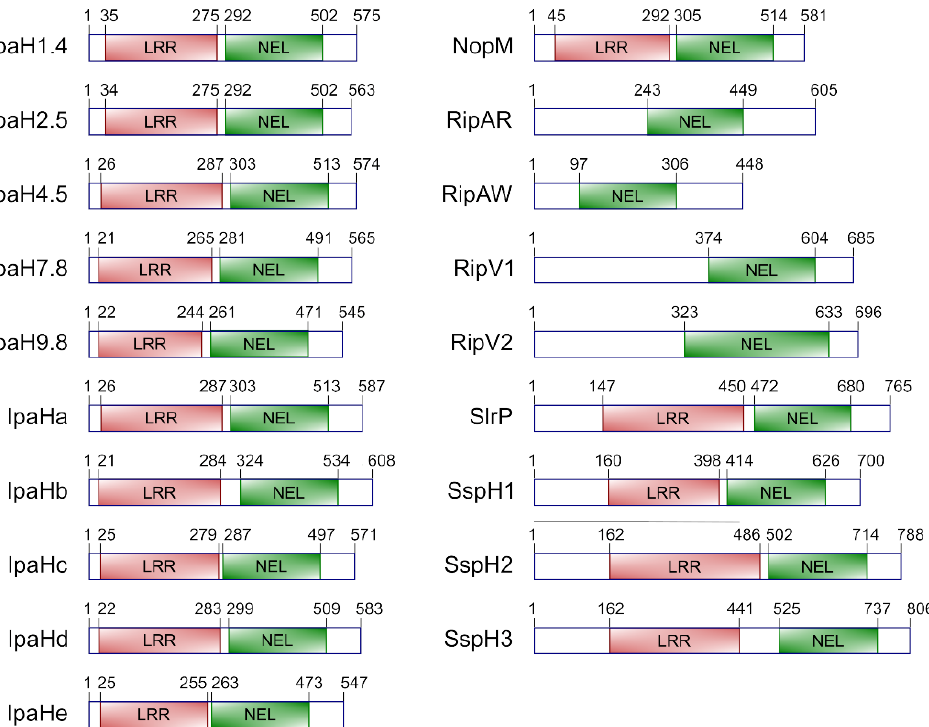
Figure 2. Diagram of domain structure of effectors of the NEL family of E3 ubiquitin ligases: IpaH proteins from S. flexneri ; NopM from S. fredii ; RipAR, RipAW, RipV1, and RipV2 from R. solanacearum ; SlrP, SspH1, SspH2, and SspH3 from S. enterica . Boundaries for each domain are numbered according to the InterProScan predictions [99].